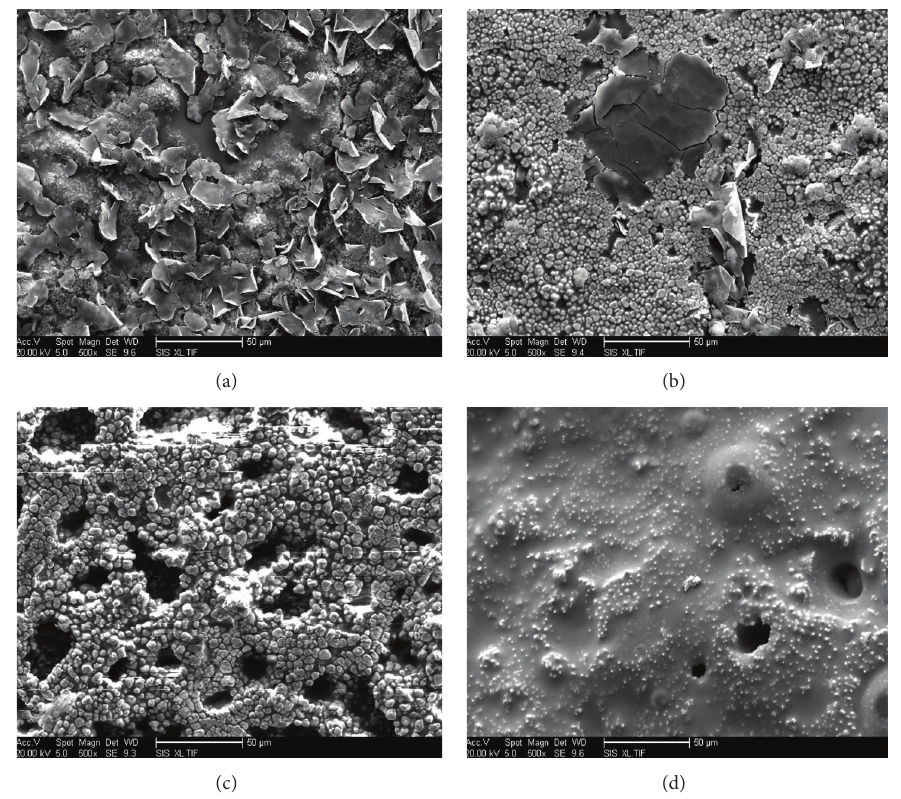
Figure 6: Surface micrographs of ZSB materials after thermal shock for 30 times: (a) 1200 ∘ C; (b) 1400 ∘ C; (c) 1600 ∘ C; (d) 1800 ∘ C.